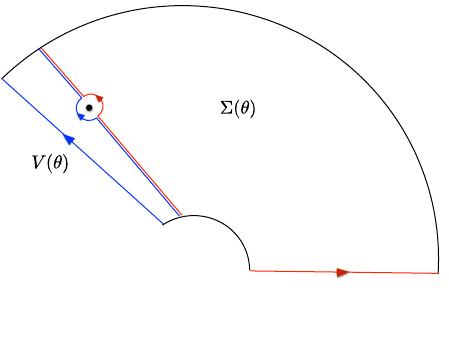
Figure 5 . The (cid:12)gure shows the modular evolution of a half space by angle (cid:18) on the regulated w plane. This is generated by the charge K ( (cid:18) ) = grated along outwardly oriented radial lines V ( (cid:18) ). Comparing this operator before (red) and after (blue) the point w (cid:6) shows that it changes by the integral of wT V + (cid:22) w (cid:22) T V along a loop encircling w (cid:6)